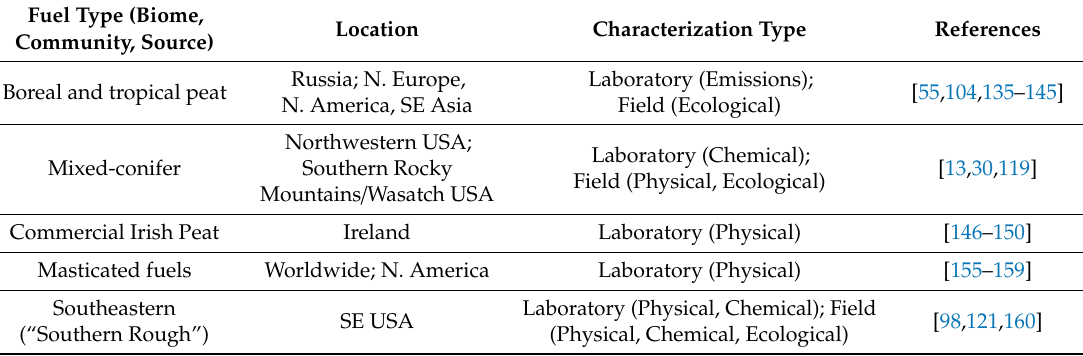
Table 3. Wildland fuels listed below have been well-characterized in regards to growth, behavior,